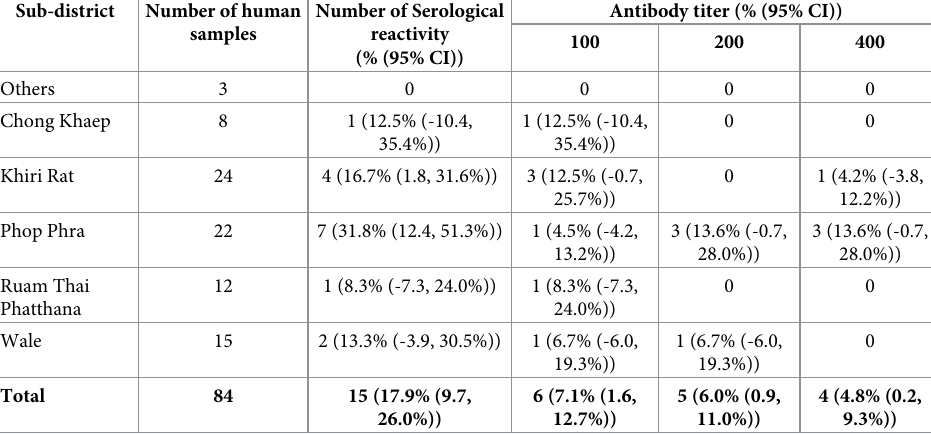
Table 5. The serological reactivity of human sera to Borrelia miyamotoi rGlpQ protein in Phop Phra district, Tak province, Thailand.